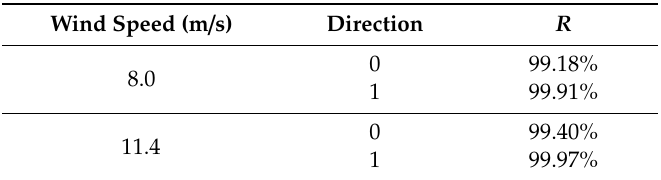
Table 10. Comparison of blade tip displacement Pearson simplified correlation coe ffi cient between elastic actuator line model (EALM) and NREL’s FAST